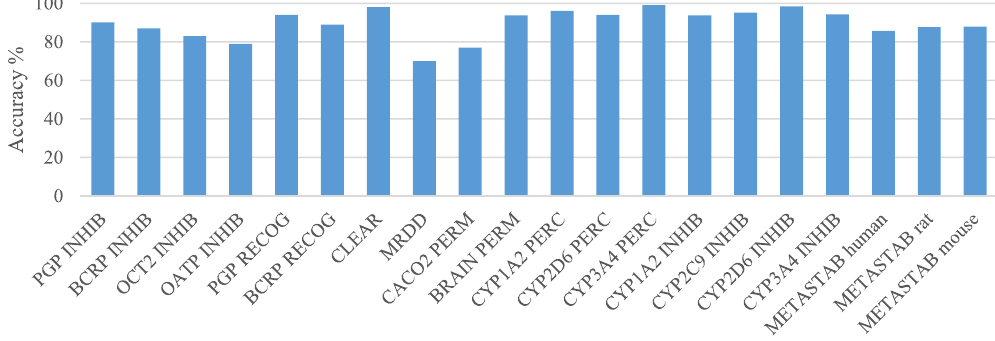
Figure 1. Accuracy values achieved by each model with external validation sets. For CACO2 PERM model, the reported value corresponds to the Matthew’s correlation coefficient.